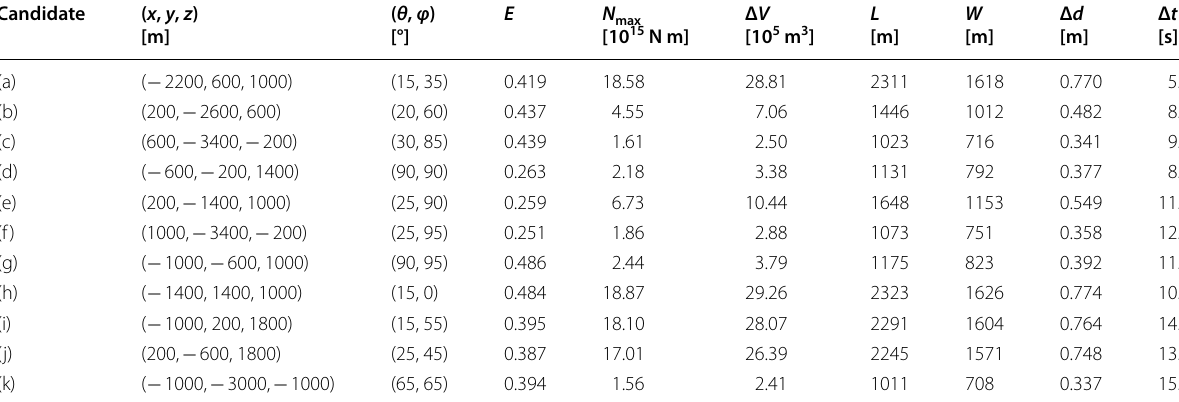
Here, ( x , y , z ) indicates the source location; ( θ , φ ) indicates the crack orientation; E indicates the residual value; N max indicates the maximum moment amplitude of the source time function; Δ V indicates the volume change; L , W , Δ d indicate the length, width, and aperture change of the crack; and Δ t indicates the time difference between the start of the eruption and the maximum amplitude of the source time function